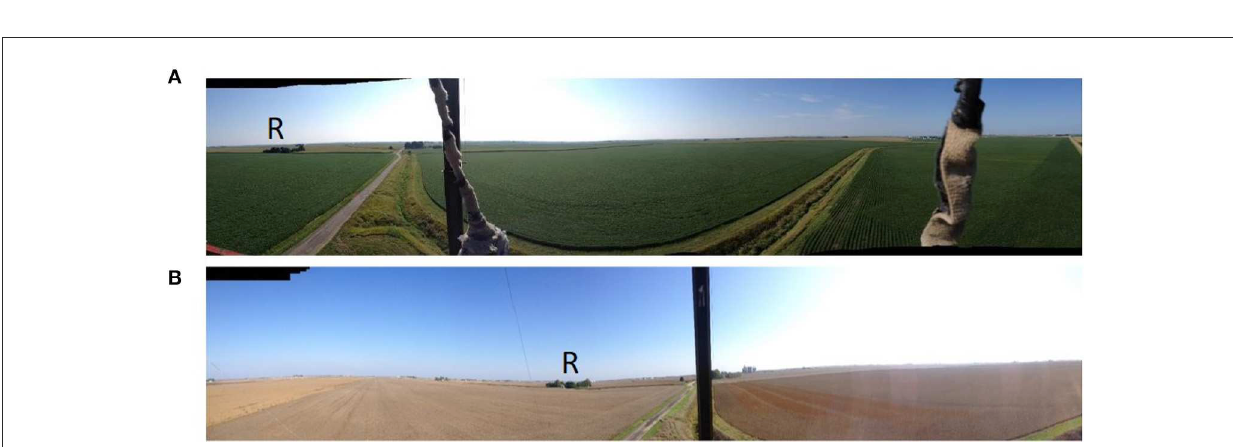
FIGURE2 Panoramic view of the intensively managed agricultural study site. (A) During the growing season in July 2015, a row crop agriculture mosaic dominates the landscape, masking features such as micro-topographic depressions and soil variability. The vegetated land cover connects the heterogeneous ecosystem and the overlaying atmosphere during the growing season. (B) Right after harvest (October 2017) only litter remains over the surface. “R" marks a common reference point between the two pictures [Photo credit: (A) AG and (B)